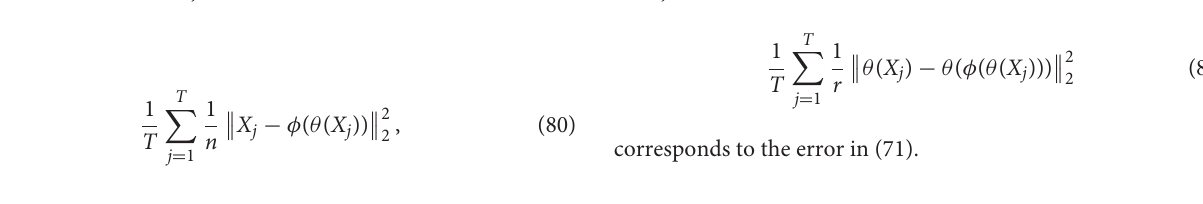
For testing we will look at two errors from the cost function, the reconstruction error,